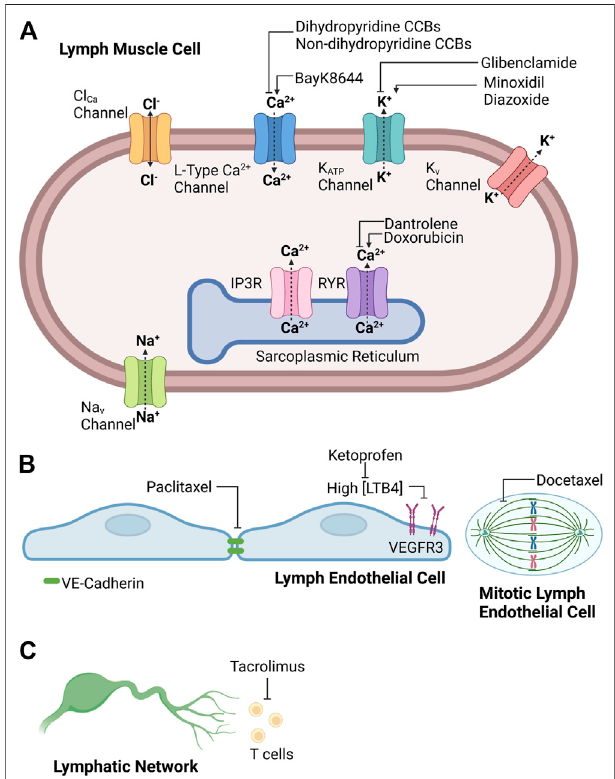
FIGURE 1 | Potential sites of drug action in (A) lymph muscle cells, (B) lymph endothelial cells, and (C) lymphatic network. Created with